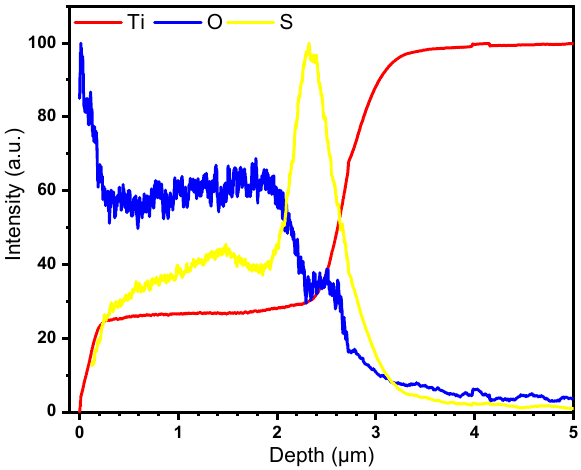
Figure A2. GD-OES in depth profile of TiO 2 film.